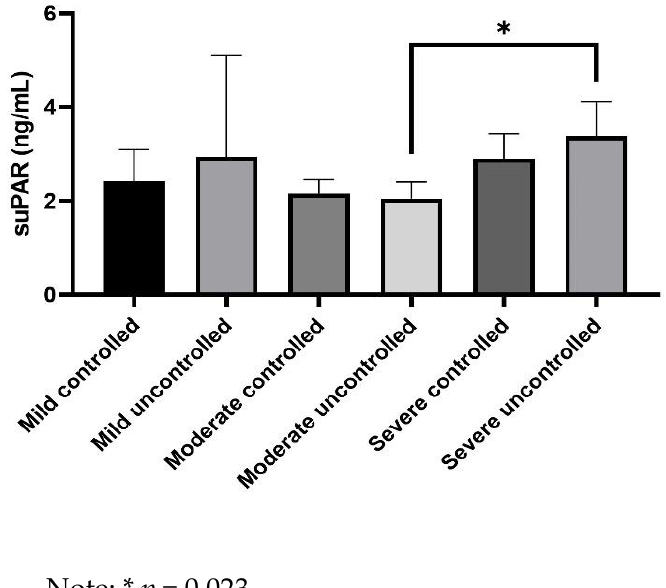
Figure 1. Comparison of serum soluble urokinase plasminogen activator receptor (suPAR) levels between groups of asthmatics.